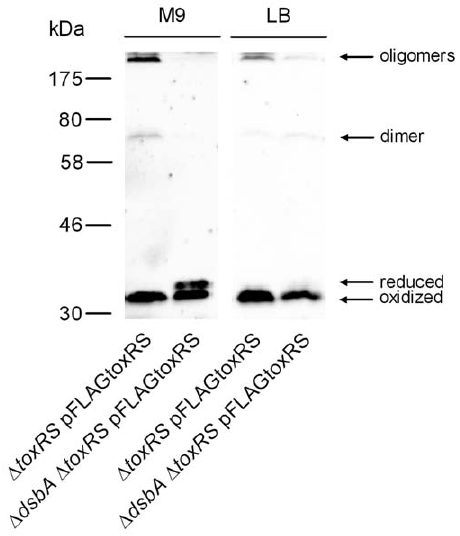
Figure 3. dsbA knockout mutant and ToxR forms. Immunoblot analyses are shown using anti-FLAG antibodies to detect FLAG-tagged ToxR produced in V. cholerae P27459-S D toxRS and D toxRS D dsbA mutant strain (as indicated in the figure). Bacterial cultures harboring pFLAGtoxRS were grown to mid-log phase in M9 glycerol and in LB broth and induced with IPTG. ToxR mobility in the different samples was monitored and differences for intrachain disulfide bond formation were detected. Immunoblot analysis was performed at least three times, and results were reproducible.